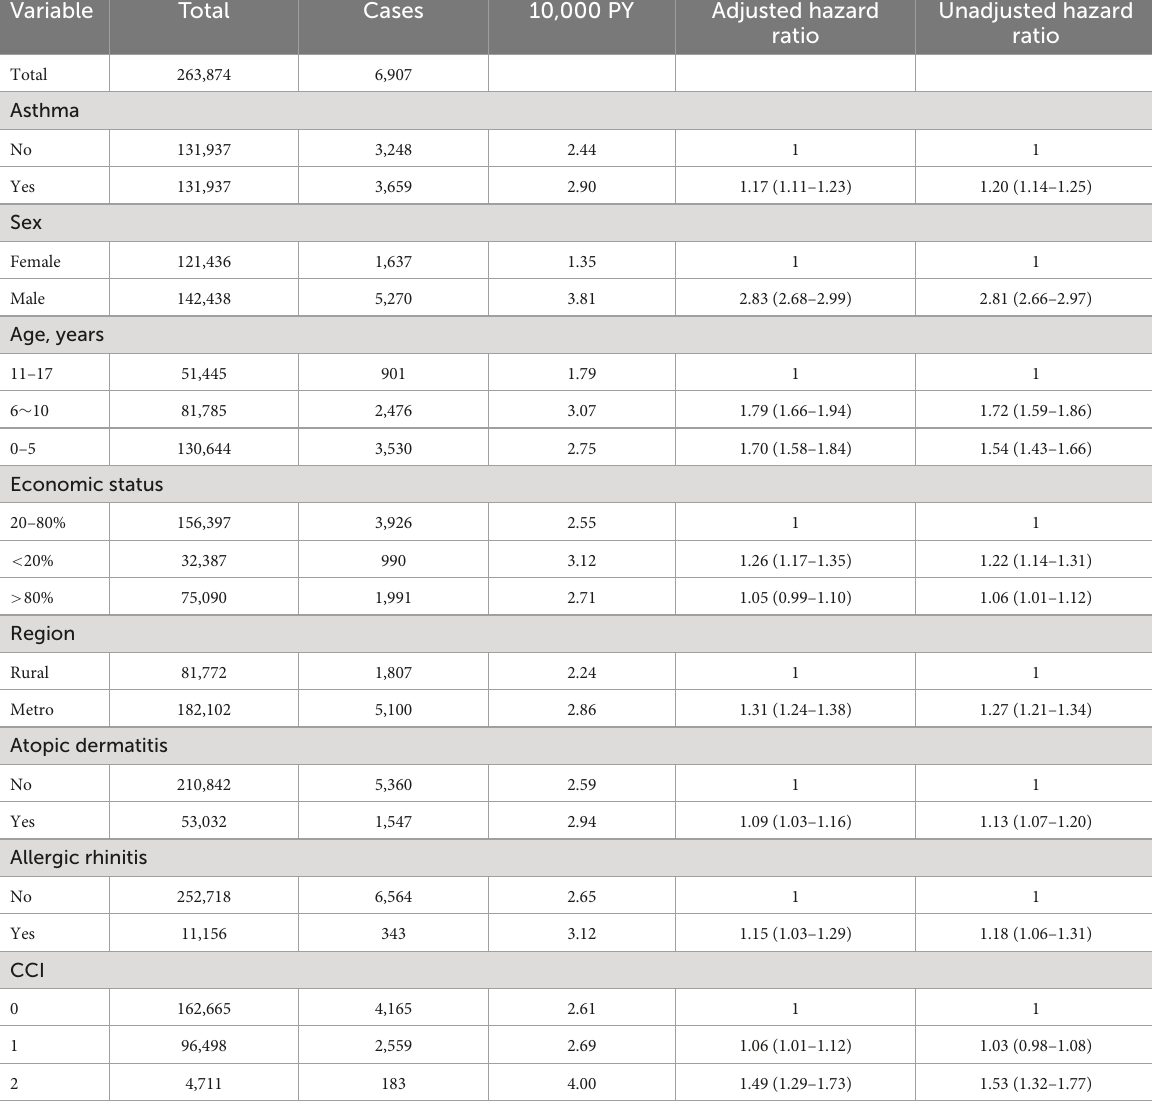
TABLE 2 Incidence rate and adjusted and unadjusted HRs for each group (Study